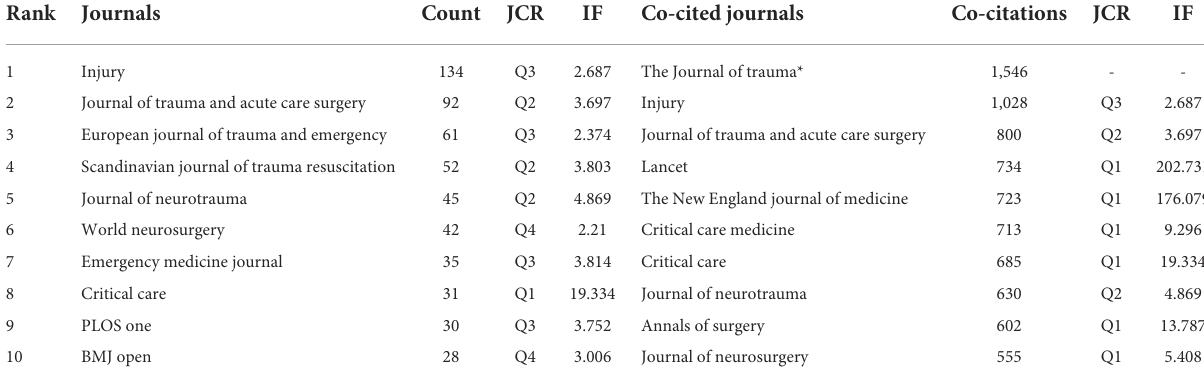
TABLE 3 The top 10 journals and co-cited